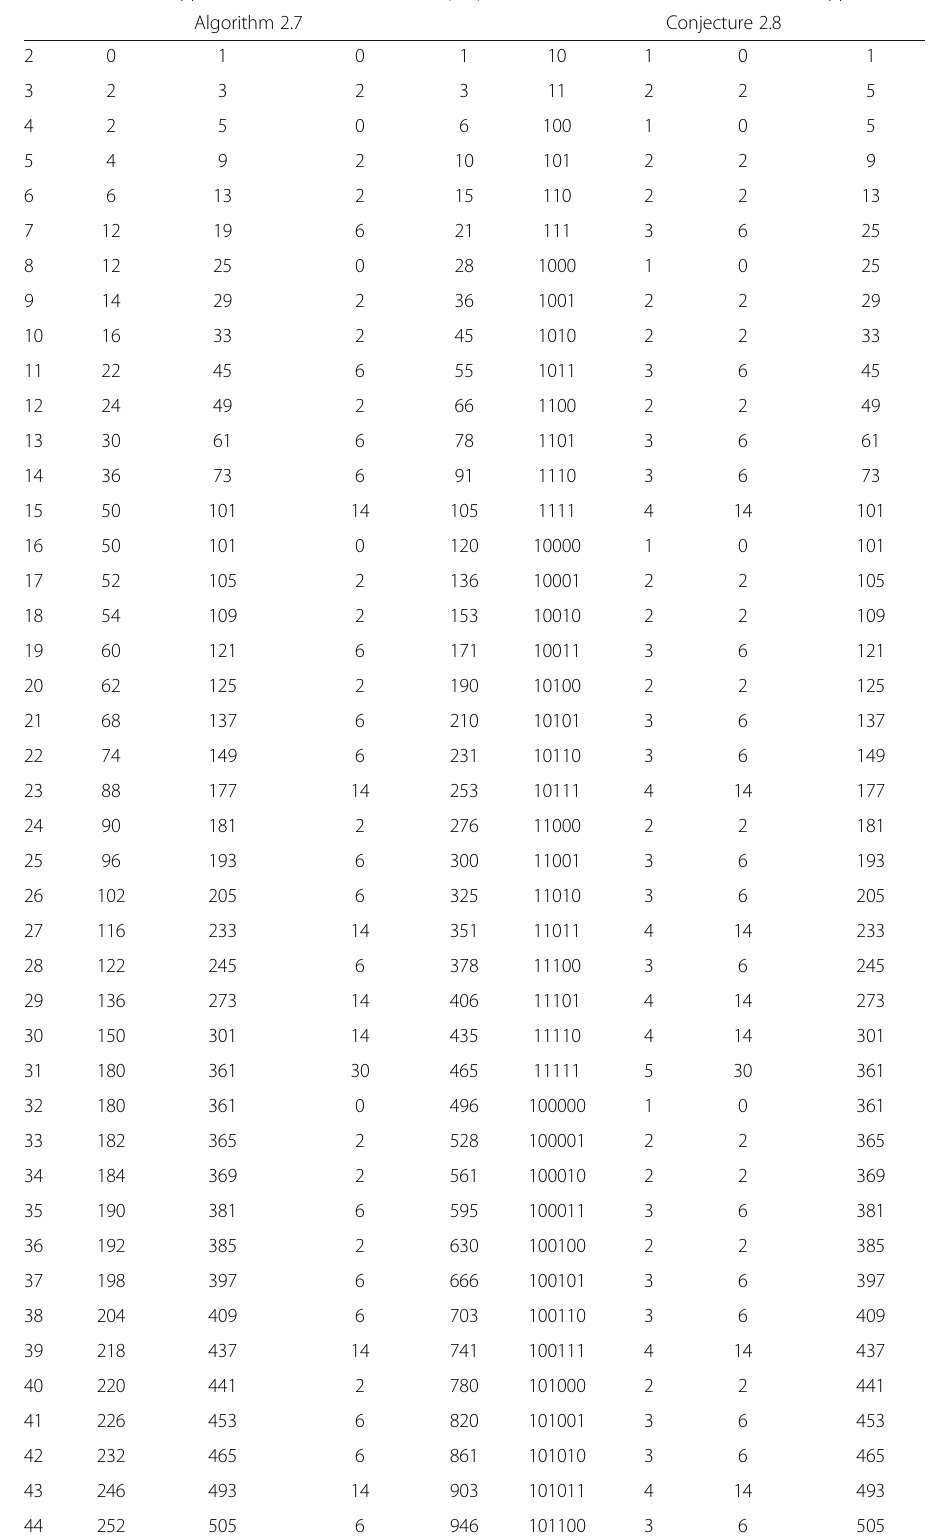
Table 2 The upper bound for the number of edges of a graph with n vertices